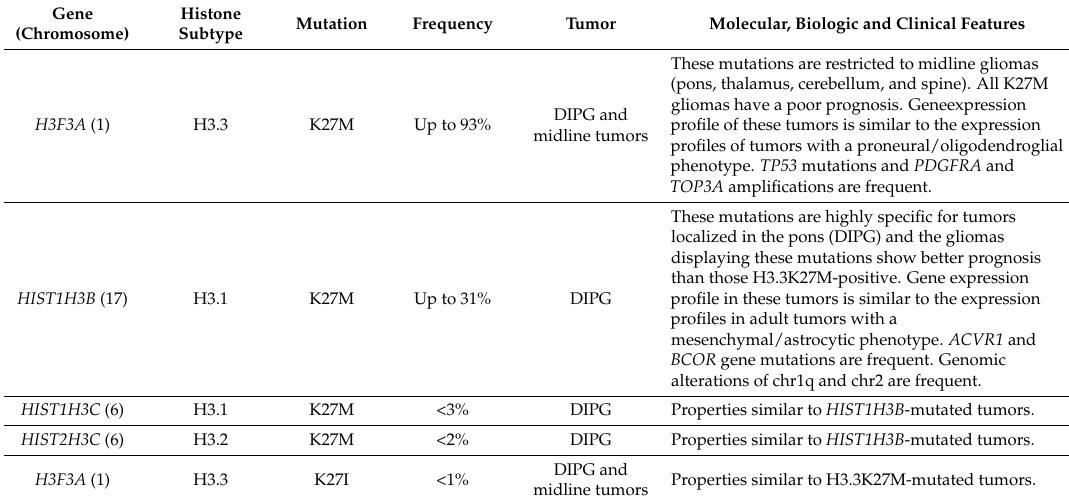
Table 4. Histone mutations reported in pediatric high-grade